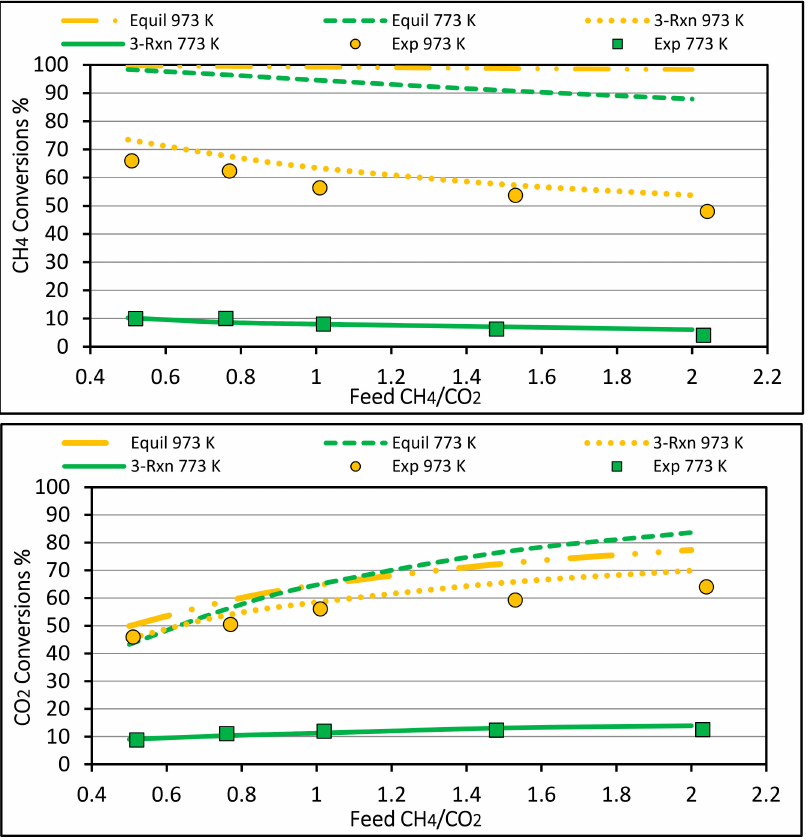
Figure 10. Impact of feed CH 4 / CO 2 on conversion of CH 4 and CO 2 at GSV = 5.56 × 10 − 4 m 3 / s-kg.